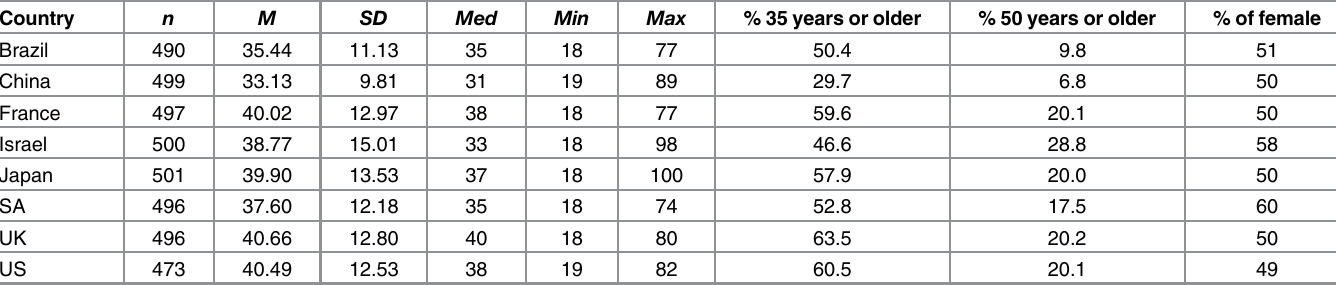
Table 1. Participant Age and Gender Distribution by